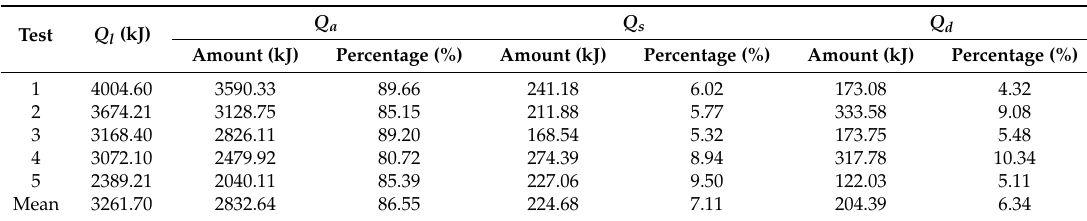
The calculation of the four heat transfer parameters of the SPDW during the dehumidification process.